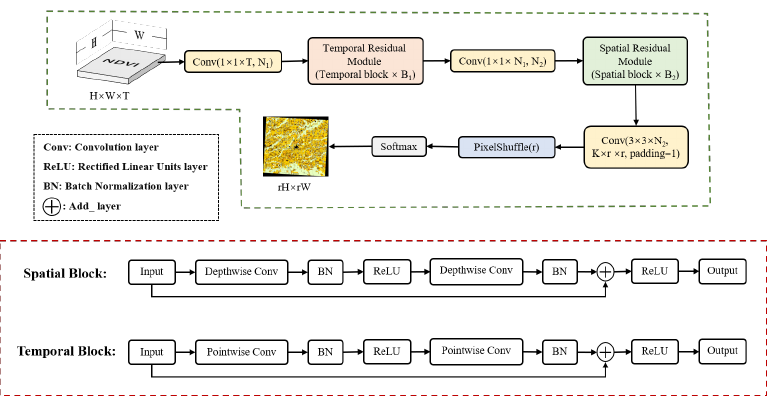
Figure 3. The framework of the ST-DRes model. As shown in the figure, the framework involves three parts. The top section (in the green dashed box) is the overall architecture of ST-DRes, while the red dashed box shows SpatRes and TempRes blocks using depth-wise convolution and point-wise convolution, respectively. The black dashed box gives the full names of some layers, which are denoted by acronyms in the